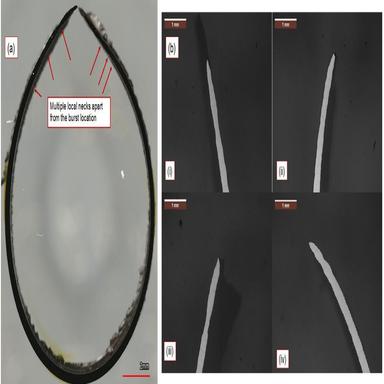
(a) Cross-sectional view of the burst (b) close view of burst microstructure at the heavily deformed sections, indicating local necks (Specimen #11).